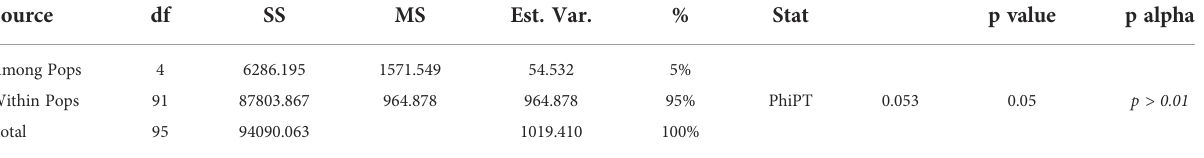
TABLE 4 Analysis of Molecular Variance (AMOVA) of western Canadian collections.